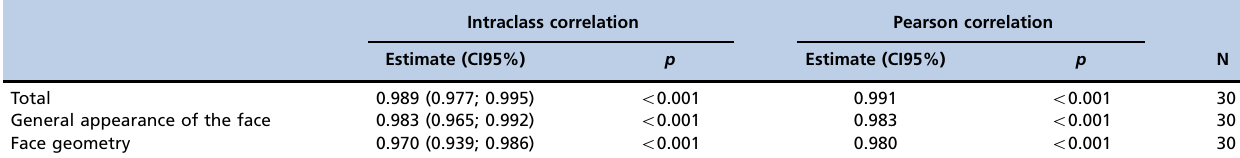
Table 2 - Intraclass correlation and Pearson (r) correlation between factors evaluated at different times.